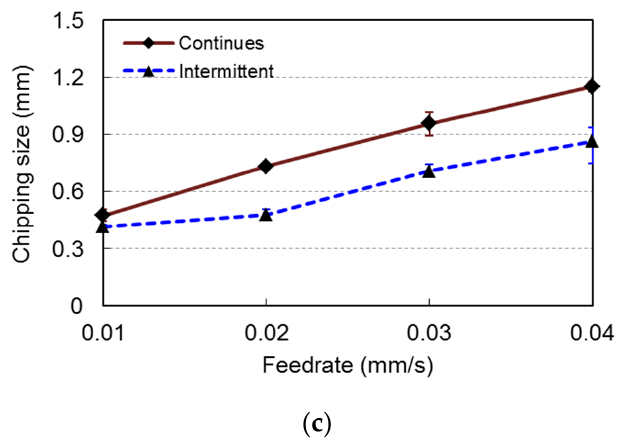
Figure 8. Effects on edge chipping. ( a ) Effects of ultrasonic amplitude; ( b ) Effects of tool rotation speed; ( c ) Effects of federate.